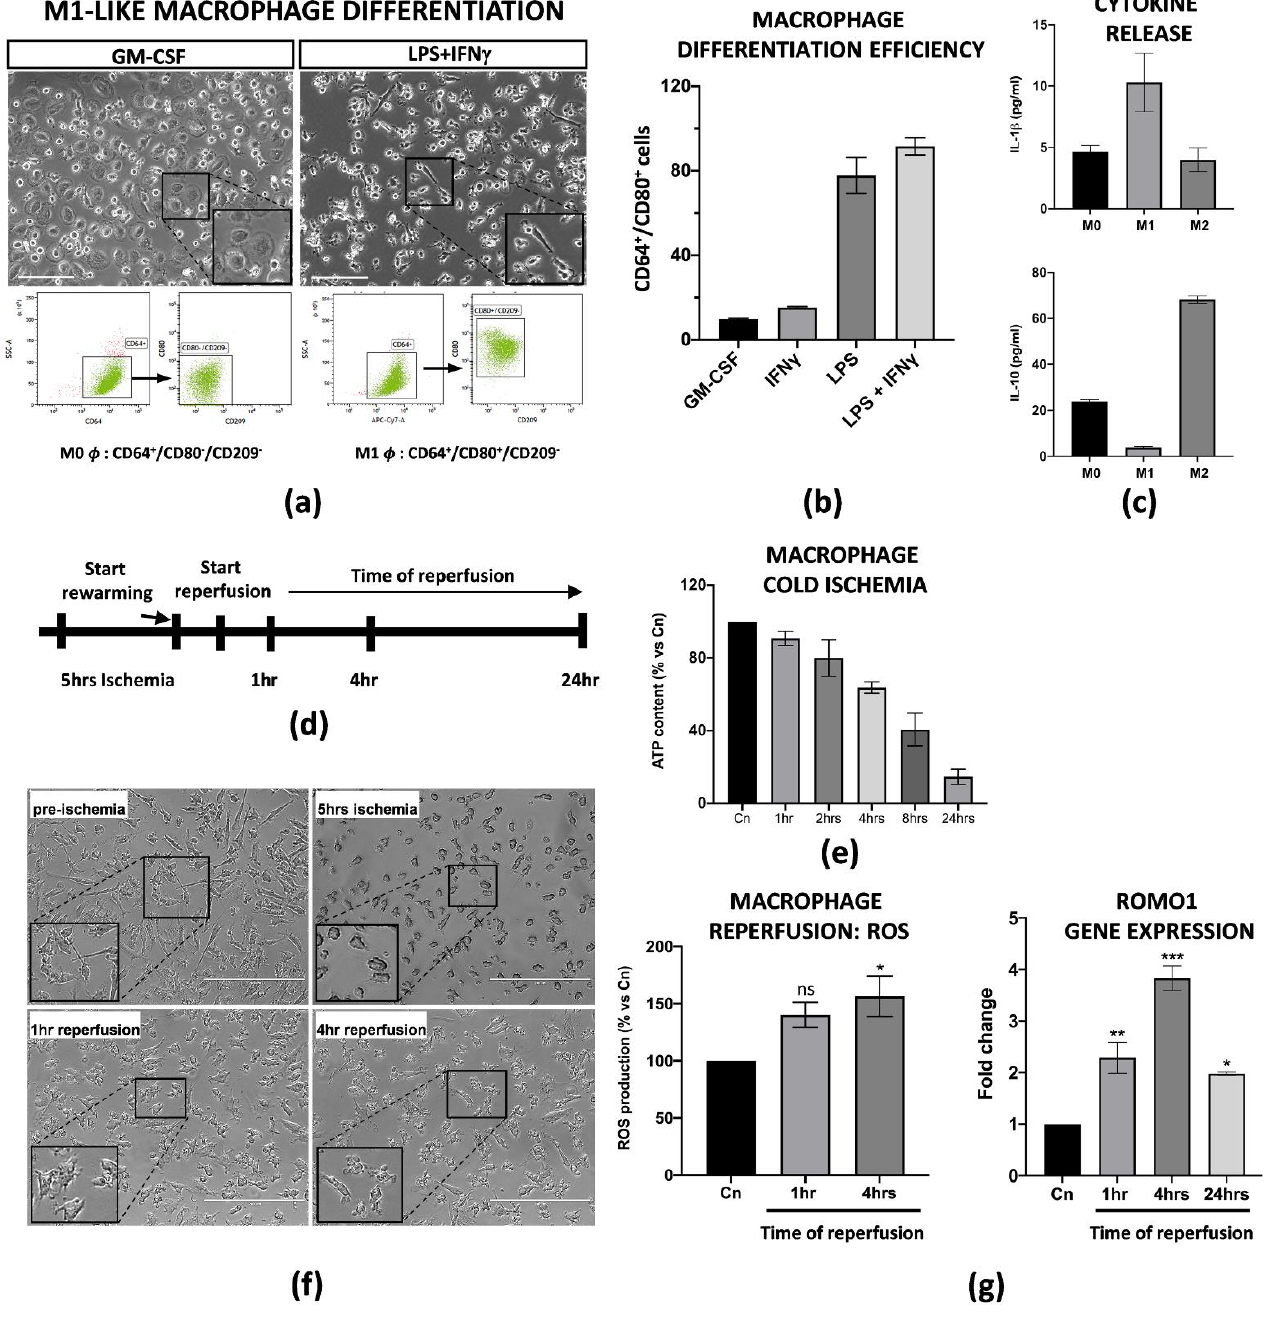
Figure 1. PBMC derived M1-like macrophages displayed an ischemic phenotype. ( a ) Flow cytometry analysis and image representation of CD14 + monocytes differentiated with GM-CSF alone or in combination with LPS + IFN γ ( n = 3). Scale bar 75 µ m. ( b ) Flow cytometry quantification of the M1-like differentiation efficiency upon treatment with GM-CSF, LPS or IFN γ alone, and LPS + IFN γ co-treatment. Data are represented as % of CD64 + /CD80 + differentiated cells for each condition treatment ( n = 3). ( c ) IL-1 β and IL-10 protein quantification in the conditioned medium of M0, M1 and M2 macrophages. Protein concentration has been calculated according to the standard curve of each ELISA assay ( n = 3). ( d ) Schematic representation of the IRI protocol applied to M1-like